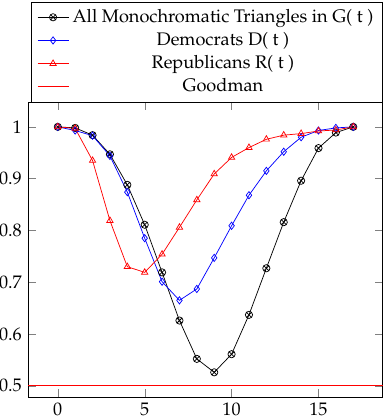
Figure 9. Transitivity percentages for the graphs G ( t ) , D ( t ) and R ( t ) , with 0 ≤ t ≤